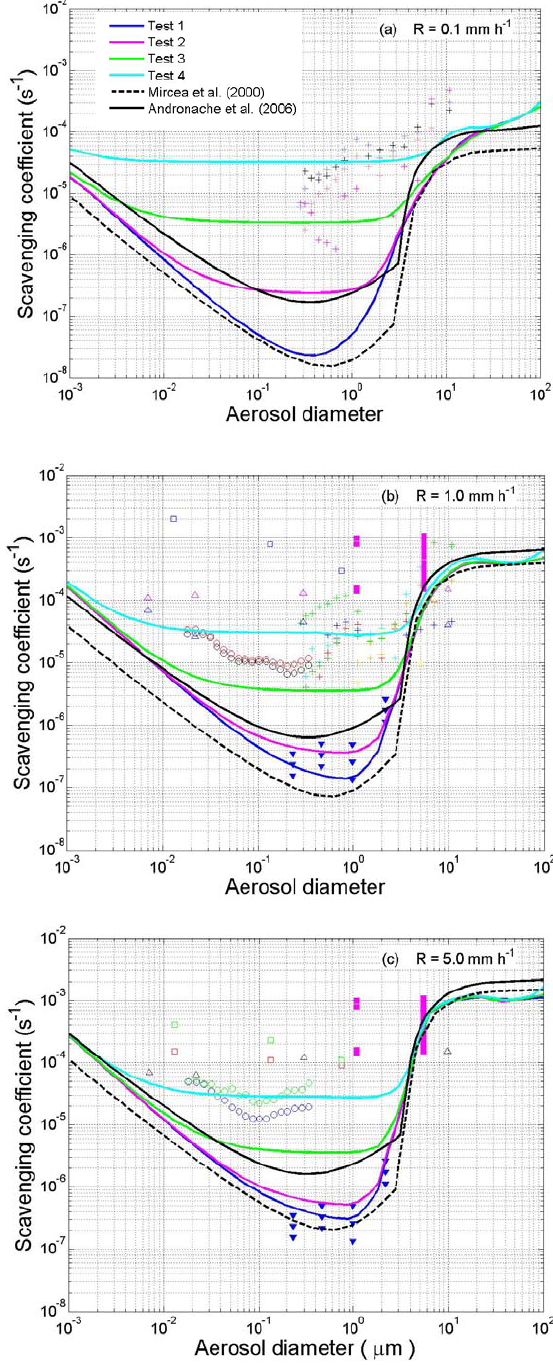
Fig. 2. Size-resolved scavenging coefficient 3 ( d) for three precip- itation intensities R calculated from model-predicted concentration changes at 16m height for tests with and without vertical turbulent diffusion (four solid colored lines). Also shown are scavenging co- efficients from two theoretical parameterizations (two black lines) representing the range of existing theoretical formulations. Avail- able measurements of 3 ( d) are copied from Wang et al. (2010) and are shown by various